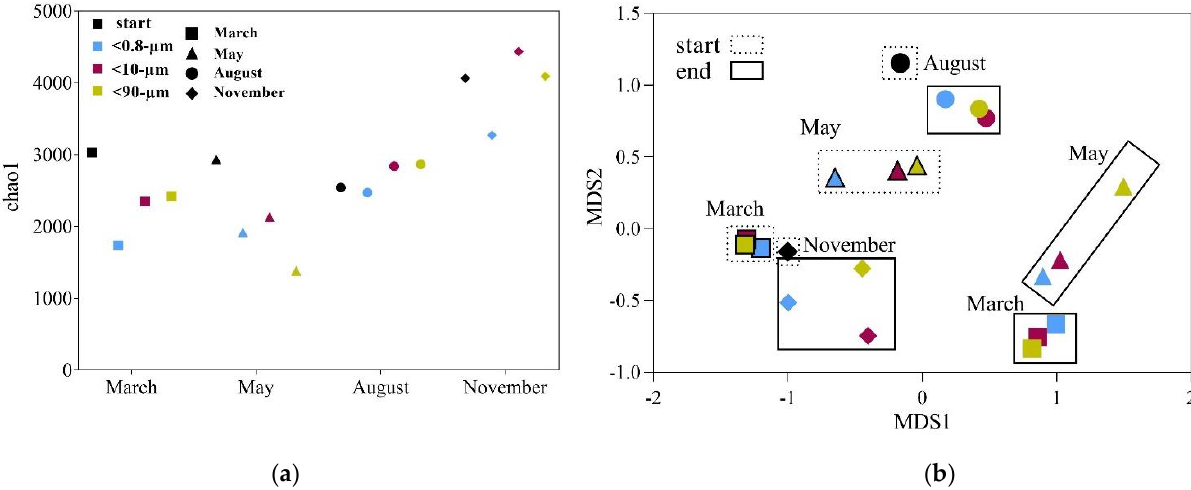
Figure 5. ( a ) Alpha diversity calculated for the estimator chao1 at the start (T 0 ) and the end (T end ) of the experiments for the three different fractions. ( b ) Multidimensional scaling (MDS) plot, illustrating the differences in community compositions between the different experiments and size fractions (<0.8- µ m, <10- µ m and <90- µ m). Colors indicate the different fractions and symbols the different months when experiments were performed. Samples representing the start conditions are grouped within dashed boxes, while samples representing the T end are grouped within solid boxes. The sample set taken for sequencing from the January experiments was incomplete, and the data is therefore not included.